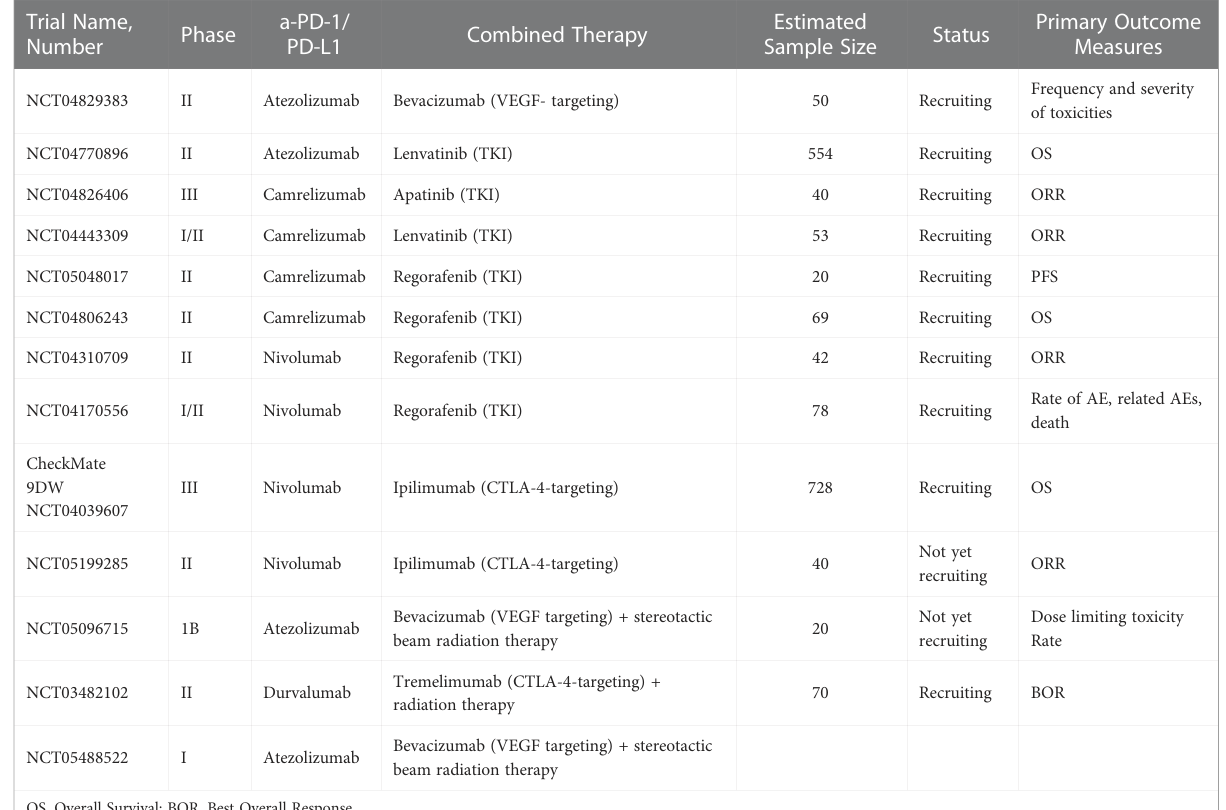
TABLE 4 Ongoing and upcoming clinical trials investigating combination therapies in